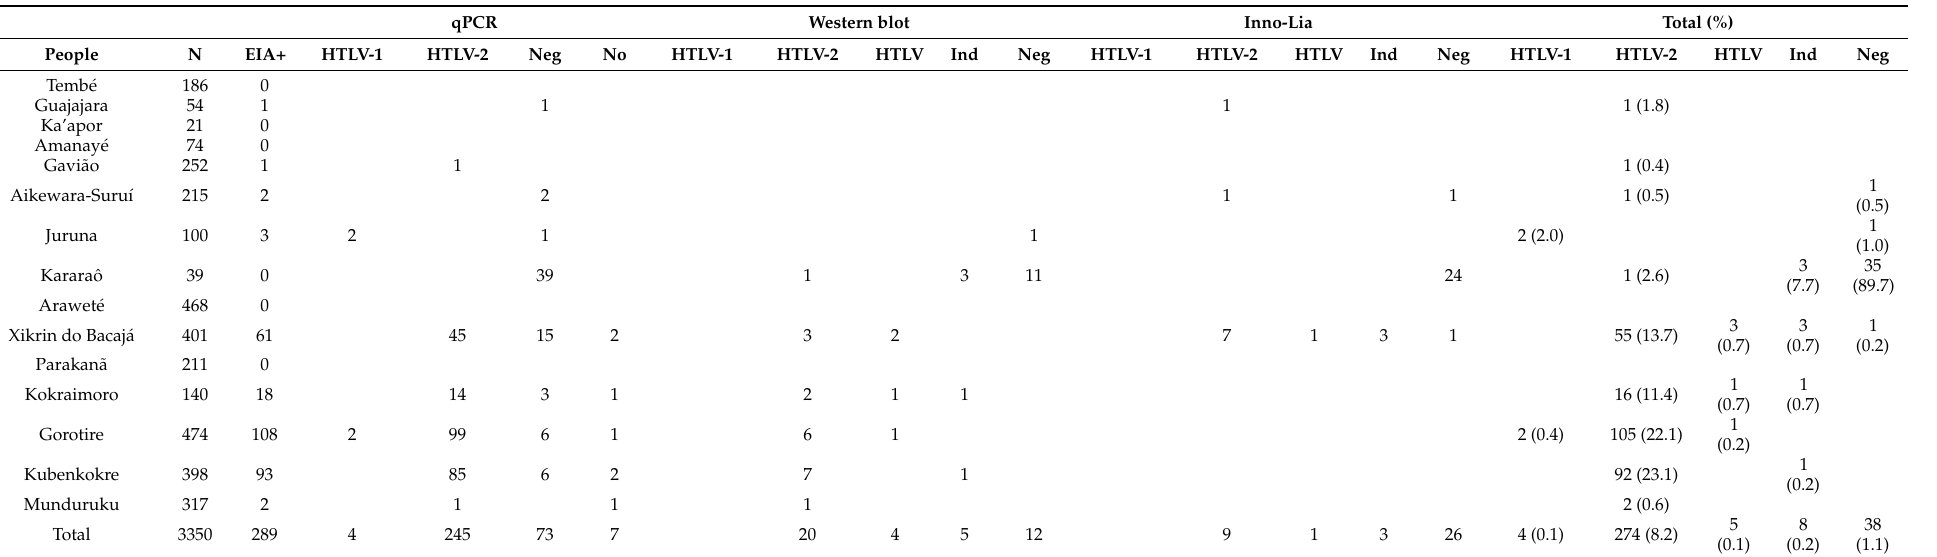
Table 2. Prevalence of HTLV-1/2 infection in Indigenous peoples of the Brazilian Amazon.